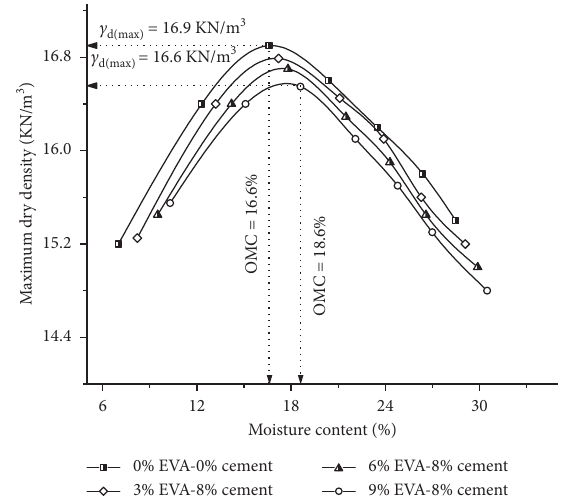
Figure 1: Compaction properties of the soil blended with cement and Table 7: Data concerning UCS and shear strength of the blended mixtures with various fractions of cement and EVA. Notations of soil mixtures